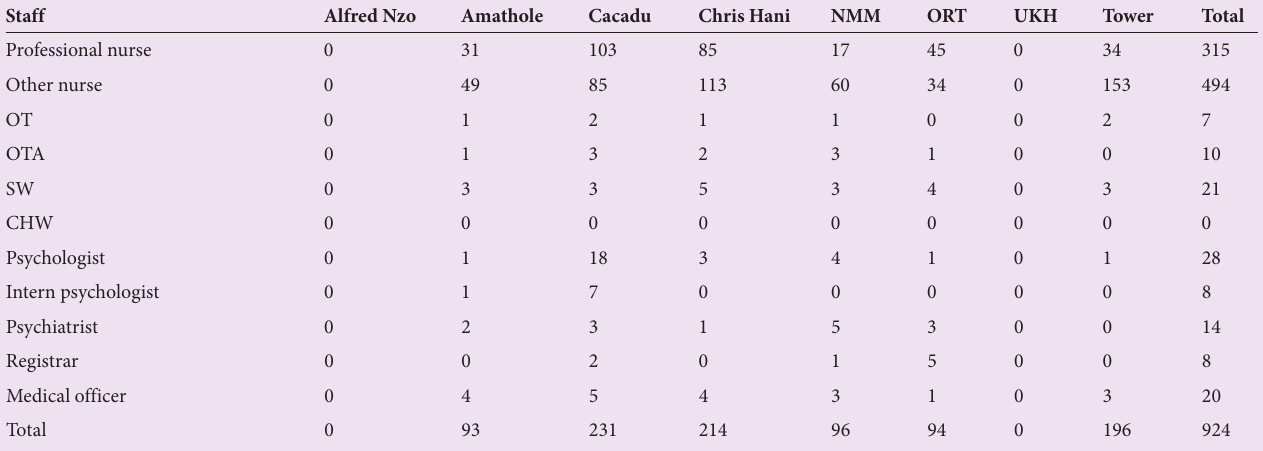
Table 3. Staff distribution per district, n